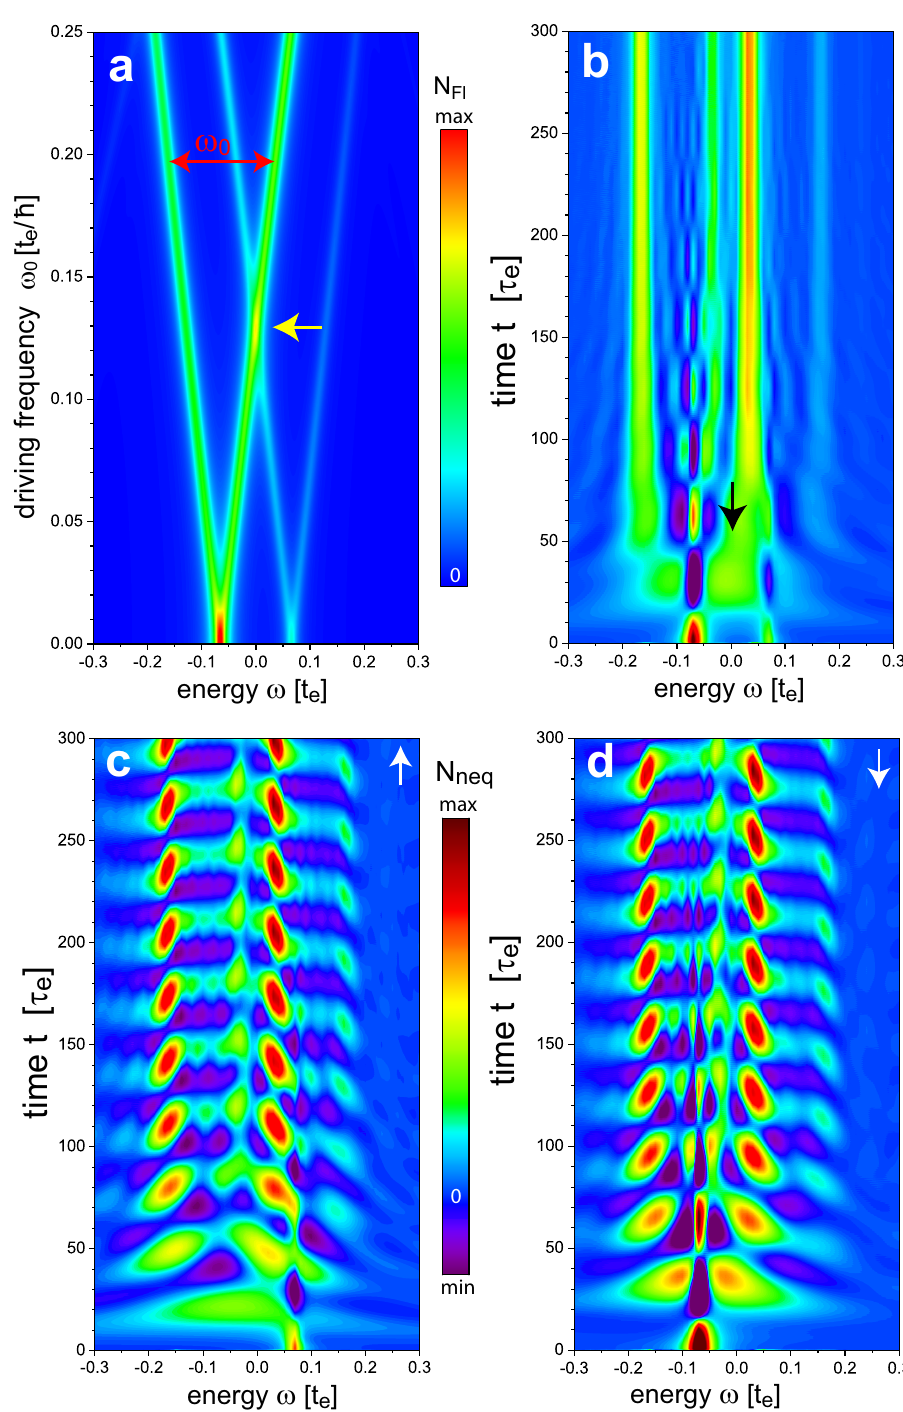
Fig. 4 Emergence of Floquet Yu-Shiba-Rusinov States. a Floquet local density of states (LDOS) N Fl as a function of energy for a continuously rotating spin with driving frequency ω 0 , with l = 2 as the cutoff in the Floquet – Sambe matrix. Note that the energy splitting of the Yu – Shiba – Rusinov (YSR) states (see red arrow) is given by ω 0 . The colorbar represents the normalized Floquet LDOS. Time evolution of b the non-equilibrium local density of states N neq ( t , ω ) summed over both spin orientations, and c the spin-resolved N neq ( ↑ , t , ω ) and d N neq ( ↓ , t , ω ) for ω 0 = 0.2 t e / ℏ , corresponding to T = 10 πτ e . The colorbar next to c represents the normalized N neq in b – d . Here, the magnetic coupling J = 2.8 t e > J c is larger than the critical value J c , where a phase transition occurs. The results for N neq were obtained for a 24 × 24 site real space